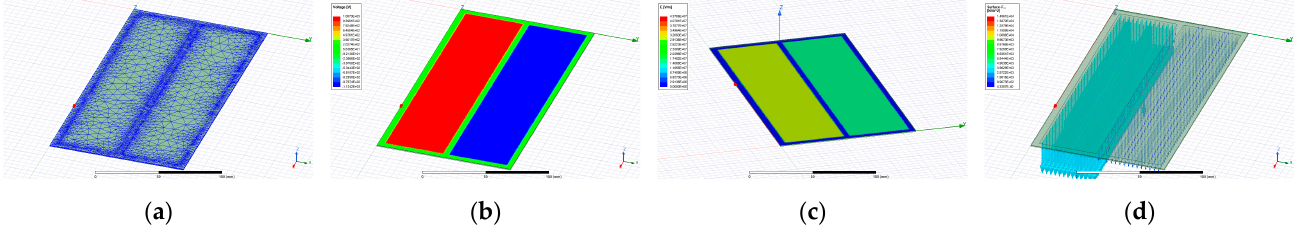
Figure 9. Dual insulation electroadhesion pad FEM analysis result: ( a ) meshing; ( b ) applied voltage; ( c ) electric field; ( d ) surface force density.